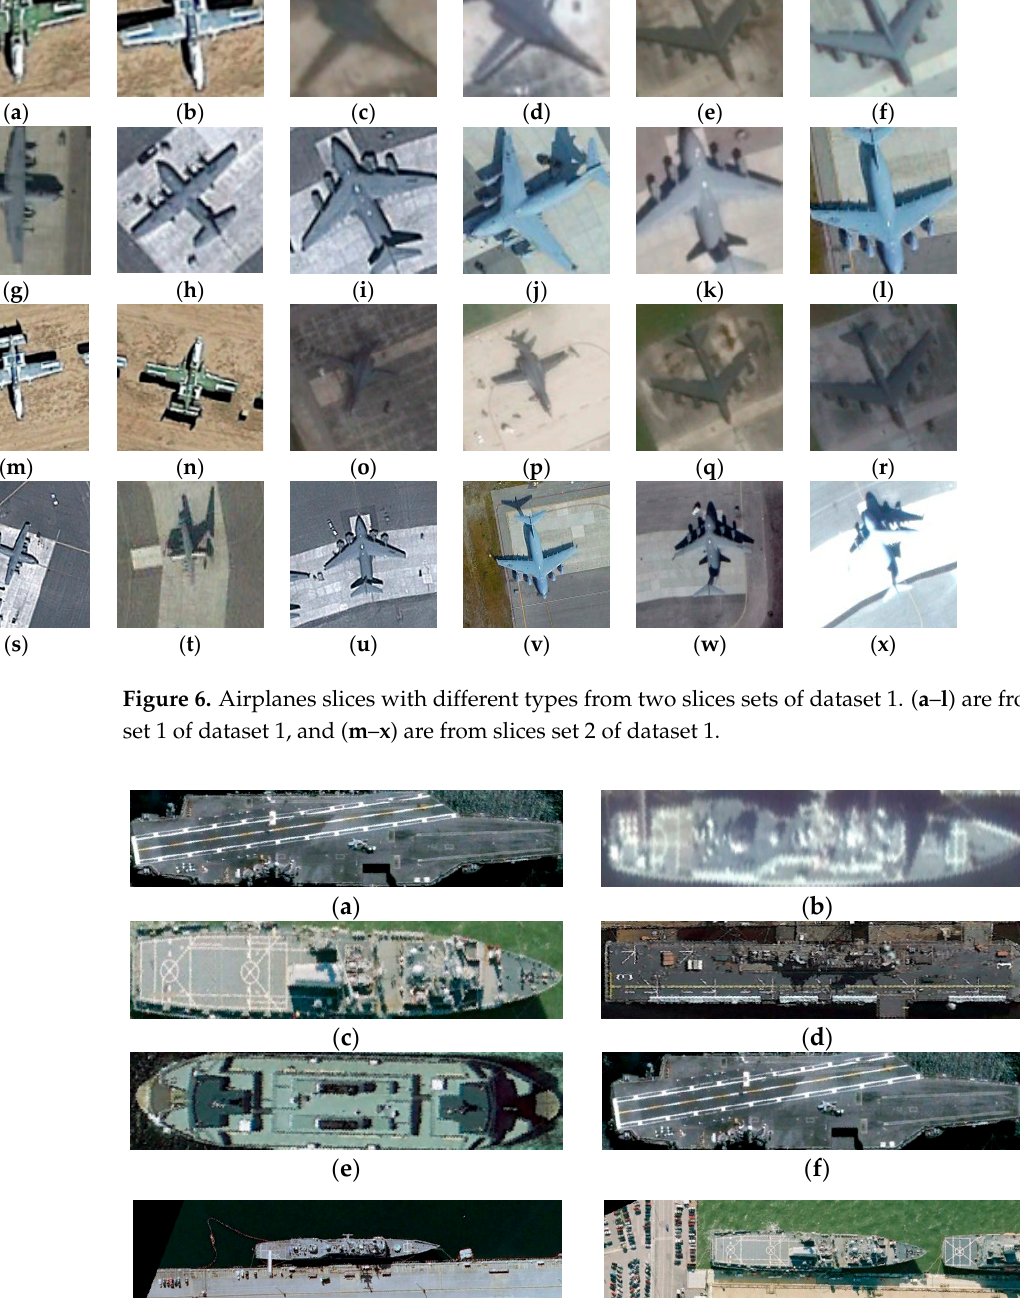
Figure 6. Airplanes slices with different types from two slices sets of dataset 1. ( a – l ) are from slices set 1 of dataset 1, and ( m - x ) are from slices set 2 of dataset 1.